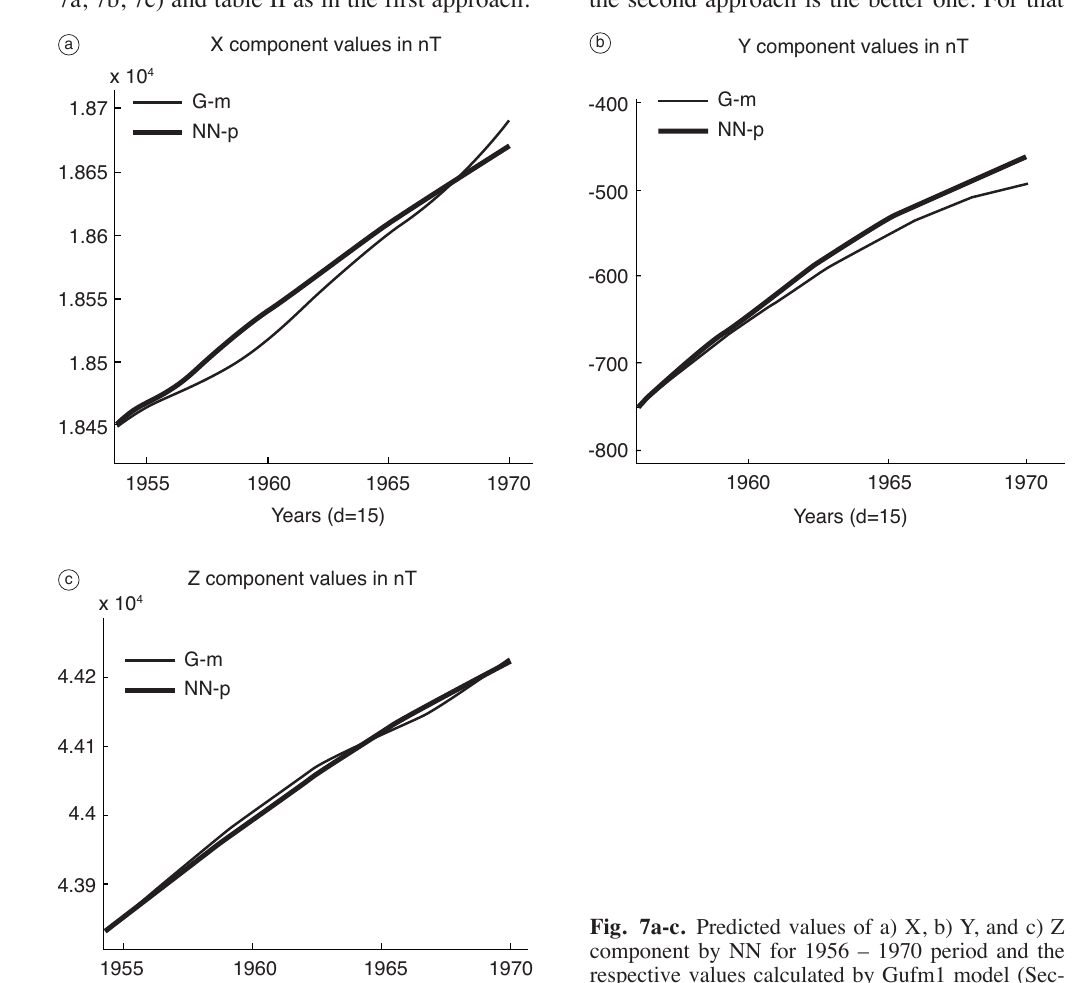
Fig. 7a-c. Predicted values of a) X, b) Y, and c) Z component by NN for 1956 – 1970 period and the respective values calculated by Gufm1 model (Sec- ond way of data